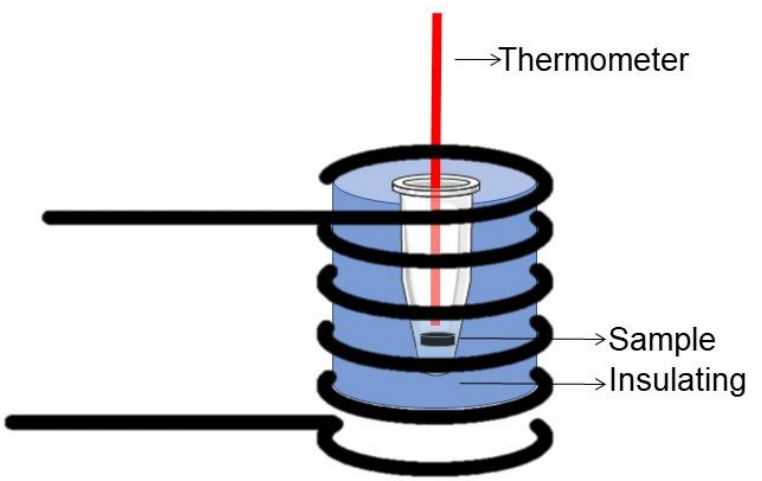
Figure 1. Schematic of the experimental setup for calorimetry measurements. The drawings were adapted from Ref. [23].